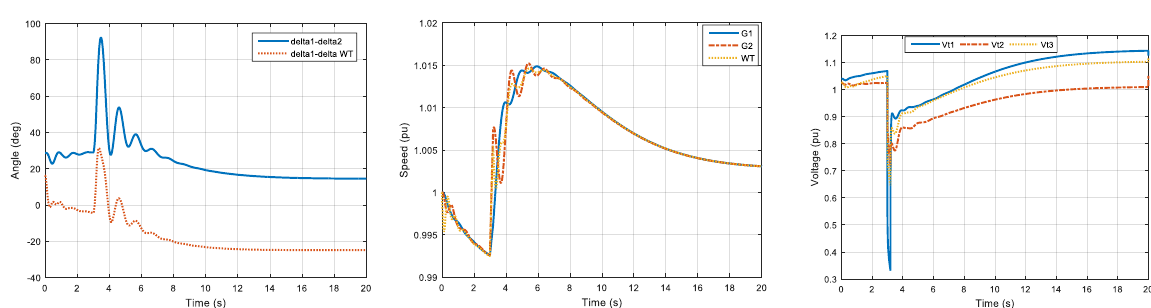
Fig.6. Simulation results with integration of wind turbine equipped by ANFIS